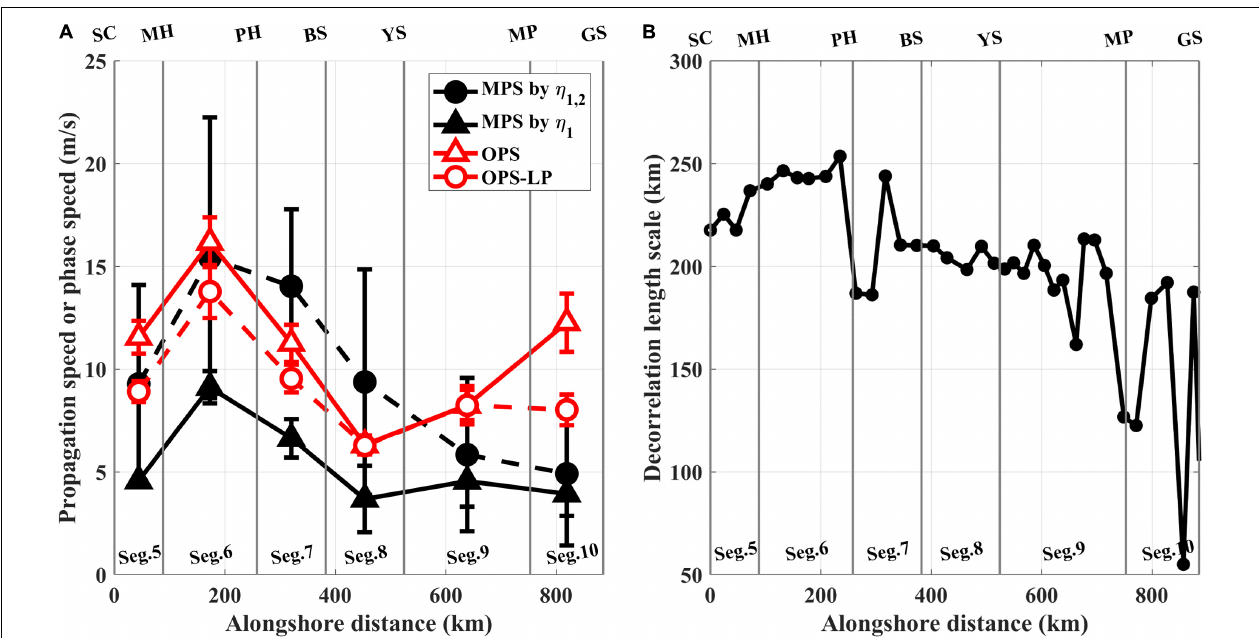
FIGURE 11 | (A) C s of MPS by η 1 , 2 (black circle and black-dashed line), MPS by η 1 (same as c 1 , black triangle and black solid line), OPS (red triangle and red solid line), and OPS-LP (red circle and red-dashed line). (B) Decorrelation length scale of τ y in